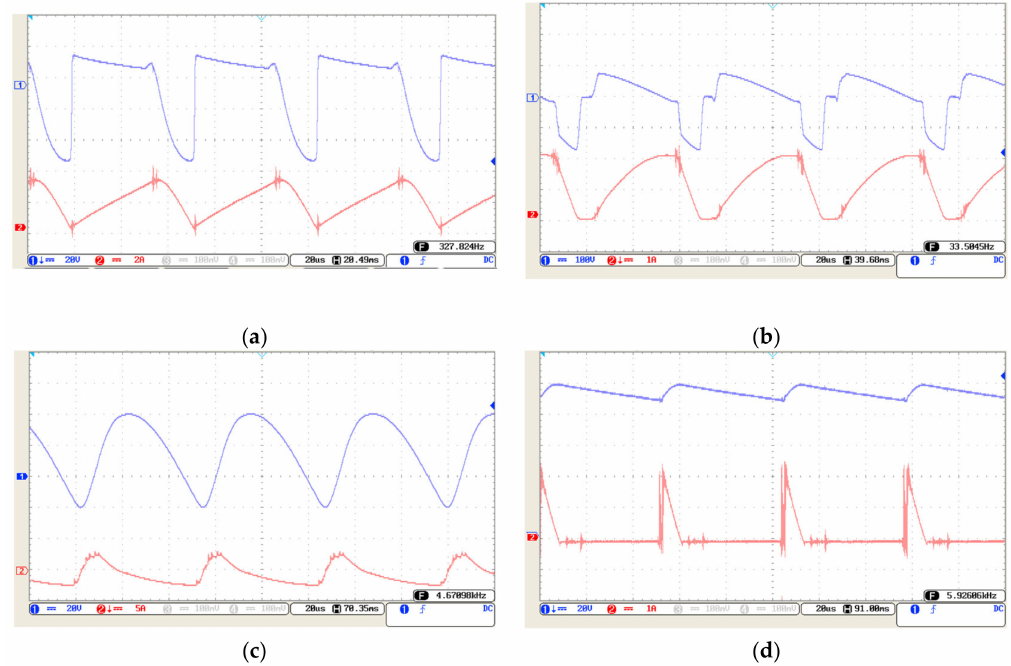
Figure 11. Experimental test waveform of output voltages and currents for the proposed multilevel inverter: ( a ) the voltage and current of L1; ( b ) the voltage and current of L2; ( c ) the voltage and current of C1; ( d ) the voltage and current of